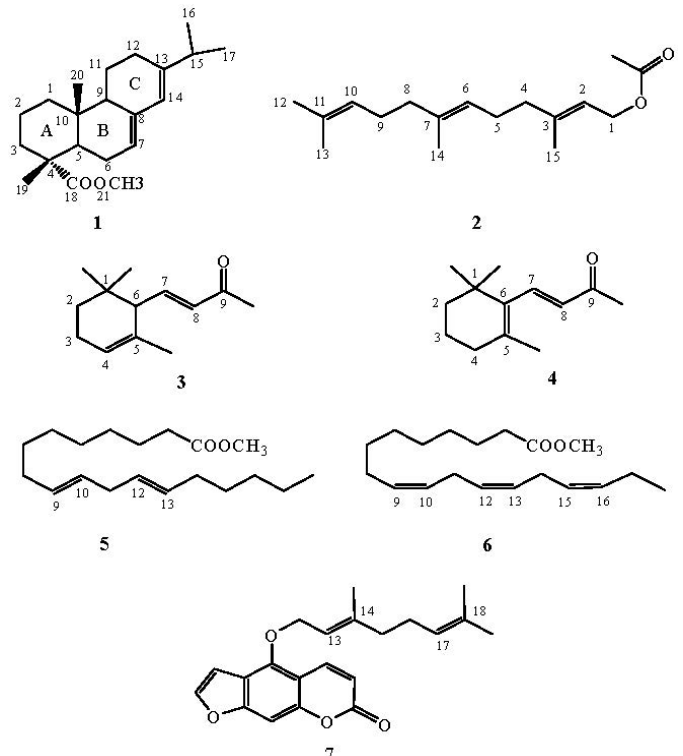
1. Selected natural compounds which undergo oxidation reactions O with MTO/H 2 2